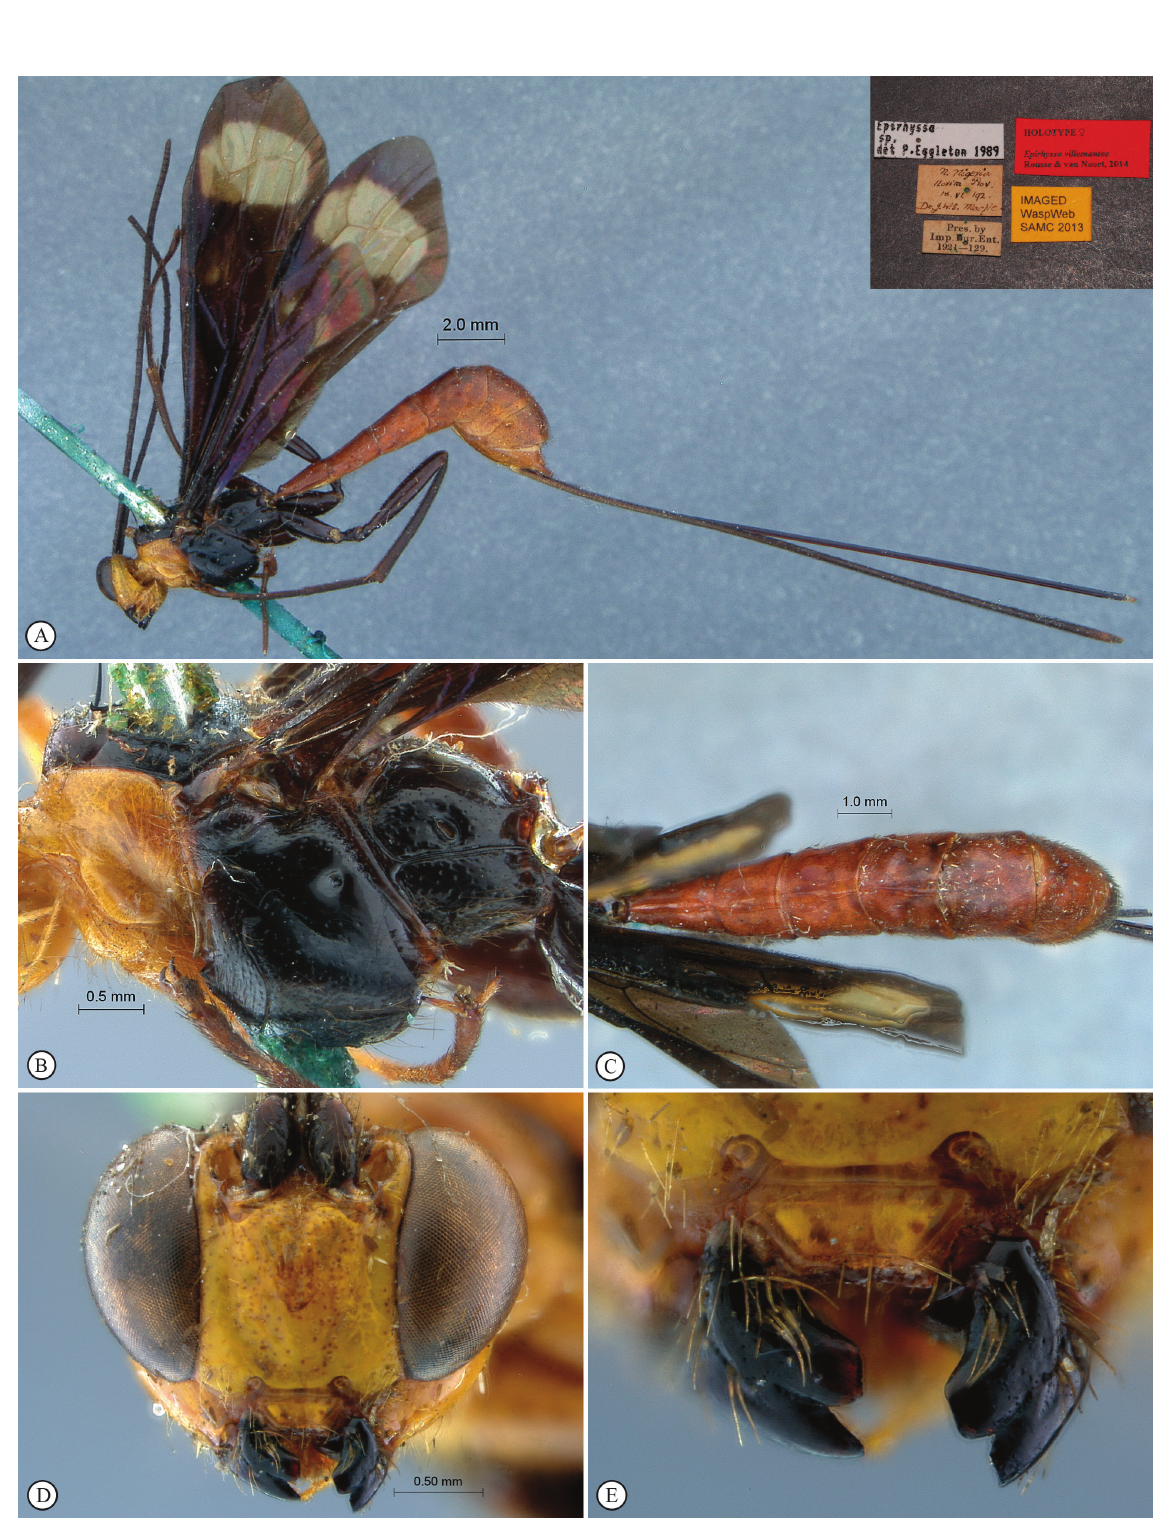
Fig. 11. Epirhyssa villemantae sp. nov., holotype, ♀. A . Habitus, lateral view (inset: data labels). B . Mesosoma, lateral view. C . Metasoma, dorsal view. D . Head, anterior view. E . Mandibles, anterior